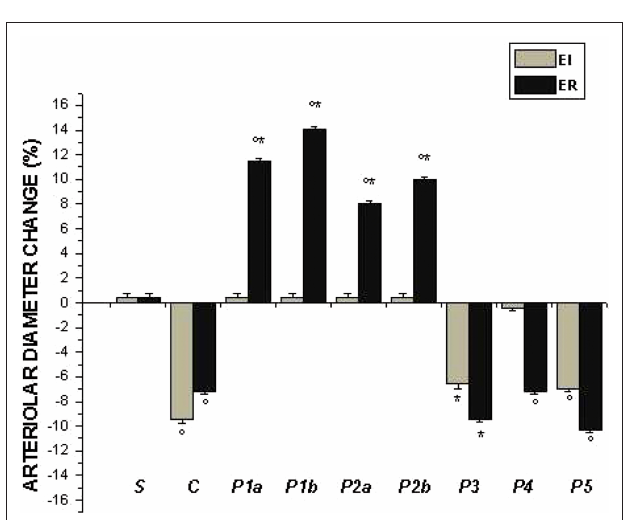
FiGuRE 3 | Percent diameter changes of A2 arterioles, at the end of ischemia (left column, Ei) and at the end of reperfusion (right column, ER) in the experimental groups, as reported in Figure 2 legend. ° p < 0.01 vs. sham-operated group, * p < 0.01 vs. C group.